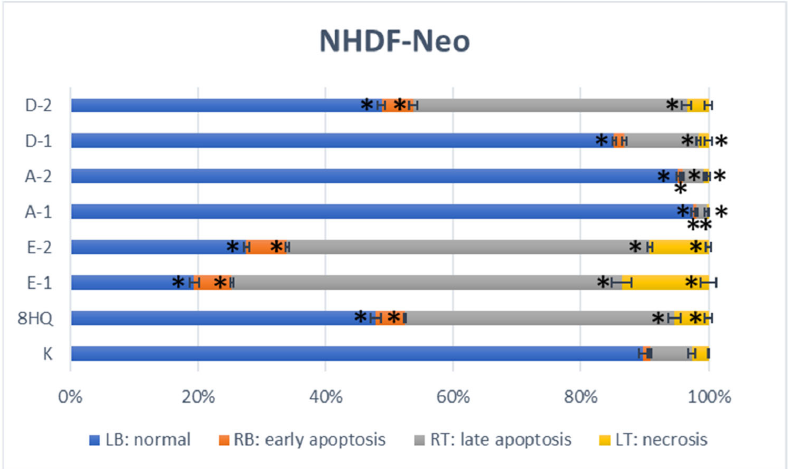
Figure 7. Flow cytometry analysis of HCT-116, MCF-7, and NHDF-Neo cell apoptosis after incubation for 24 h with test compounds used in their IC 50 doses. The fractions of dead cells were detected by the FITC Annexin-V Apoptosis Detection Kit with PI. Means ± SD from three independent experiments. * p ‐ value < 0.05, in comparison to the control.